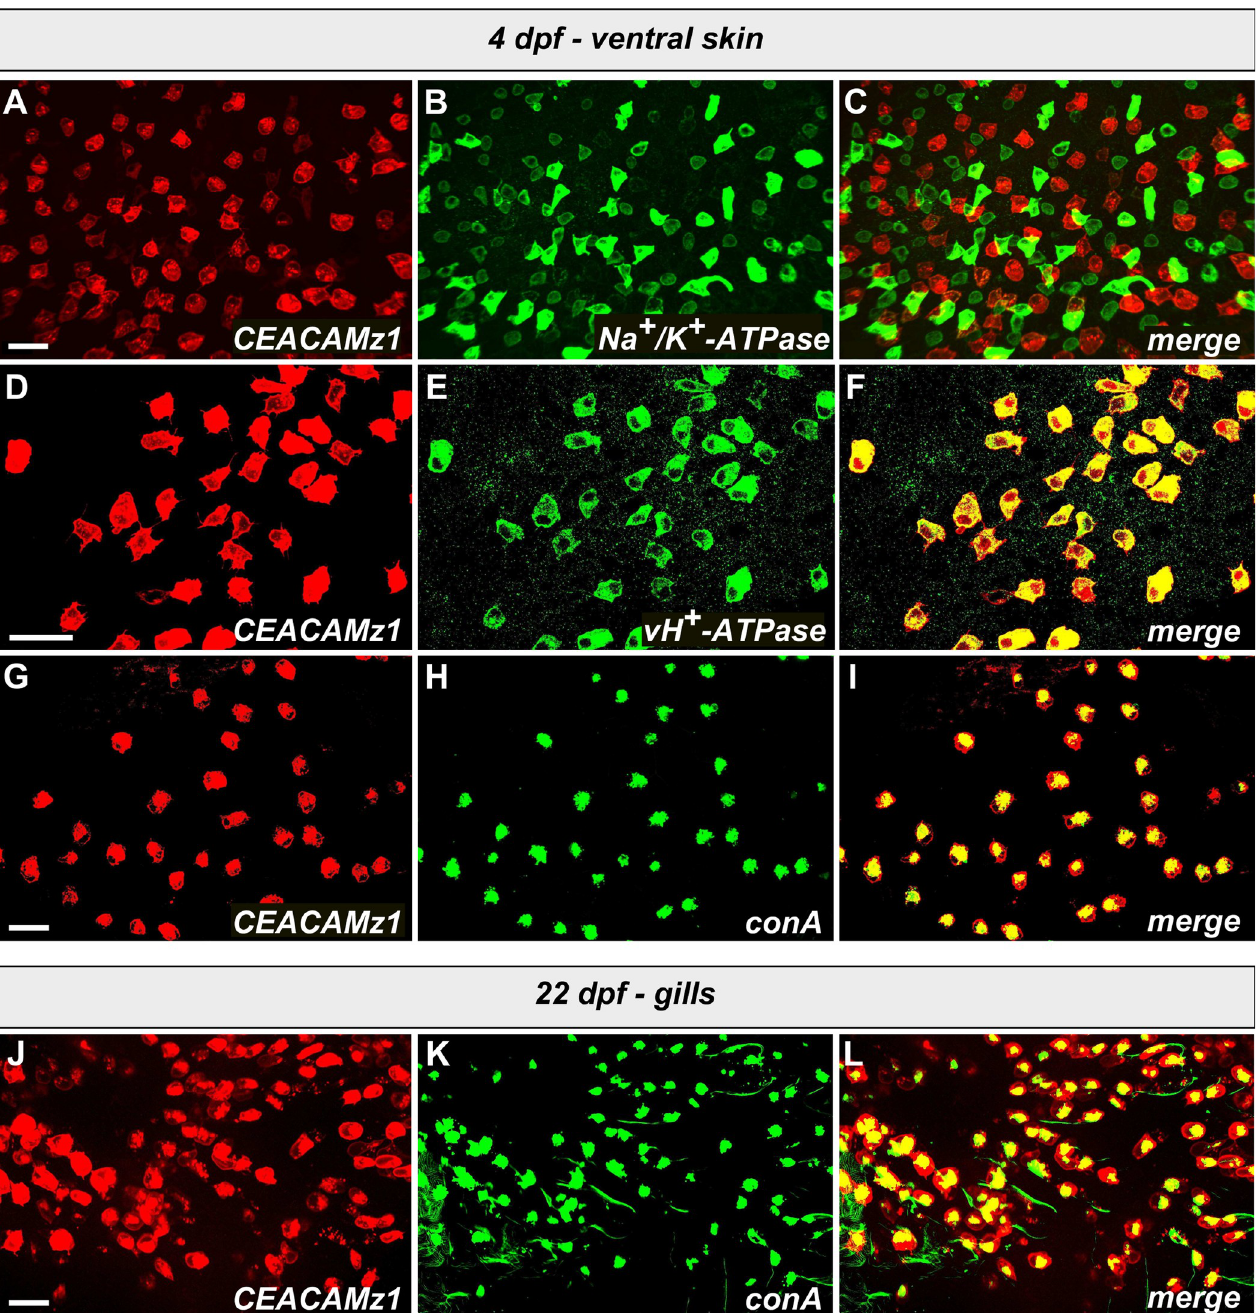
Fig 6. Identification of the ionocyte subtype that expresses CEACAMz1 on zebrafish epidermis. A-C. High magnification view of the yolk sac surface of a 4 dpf Tg(ceacamz1 : mCherry-F) larva ( A ) immunolabelled with anti-Na + /K + -ATPase antibody ( B ); merge of A and B ( C ). D-F. High magnification view of the yolk sac surface of a 4 dpf Tg(ceacamz1 : mCherry-F) larva ( D ) immunolabelled with anti-vH + -ATPase antibody ( E ); merge of D and E ( F ). G-I. High magnification view of the yolk sac surface of a 4 dpf Tg(ceacamz1 : mCherry-F) larva ( G ) co-stained with Alexa Fluor 488-conjugated conA ( H ); merge of G and H ( I ). (J-L) High magnification view of the gill region of a 22 dpf Tg(ceacamz1 : mCherry-F) larva ( J ) co-stained with Alexa Fluor 488-conjugated conA ( K ); merge of J and K ( L ). At all stages analyzed, CEACAMz1-expressing cells perfectly co-localize with cells labelled by the vH + -ATPase antibody or by conA. They do not overlap at all with the cells labelled by the Na + /K + -ATPase antibody.